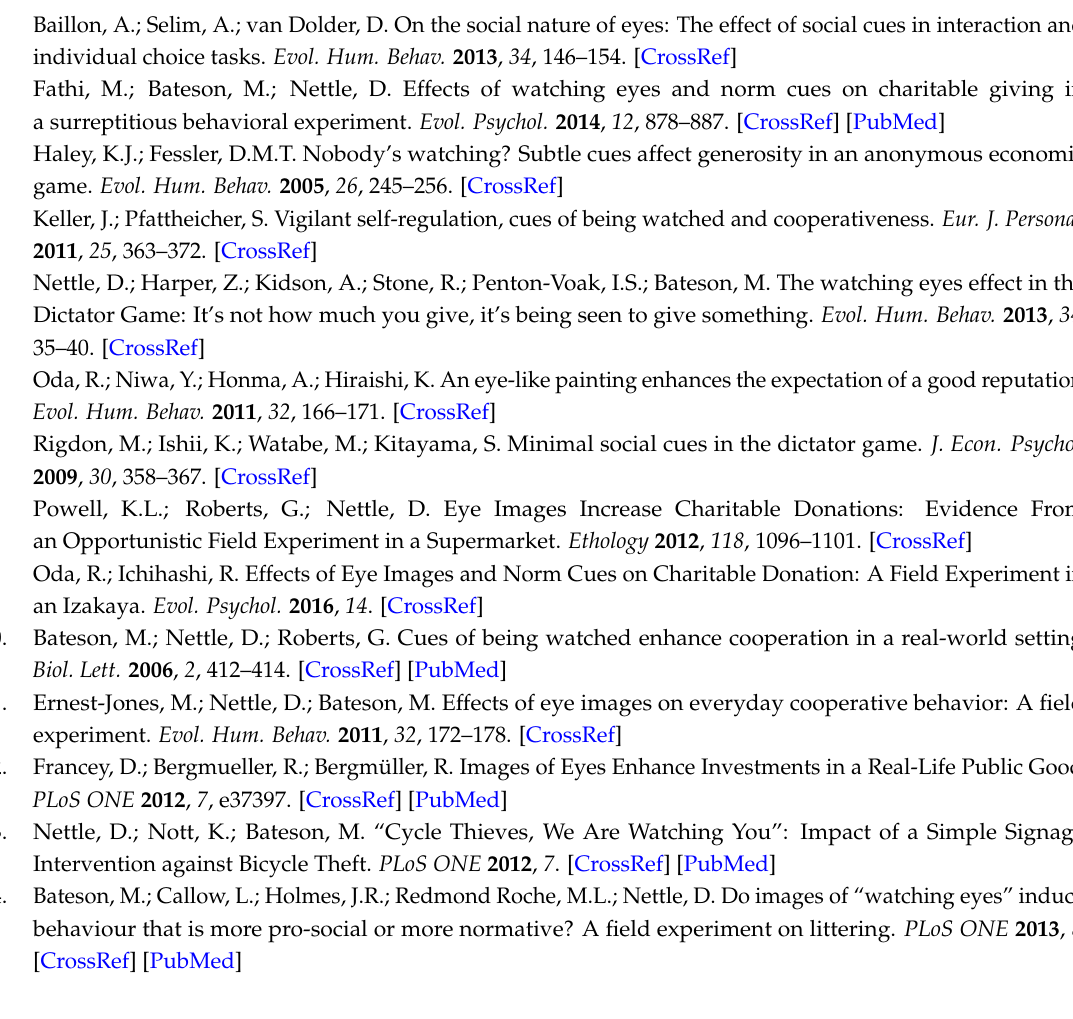
Figure S1: A screenshot of the first mover decision., Figure S2: A screenshot of the second mover decision. Table S1: Logistic regression estimates of the impact of SVO, eyes, kind eyes (K eyes), unkind eyes (UK eyes), gender, age and power on trust, Table S2: Logistic regression estimates of the impact of SVO, eyes, kind eyes (K eyes), unkind eyes (UK eyes), gender, age and power on